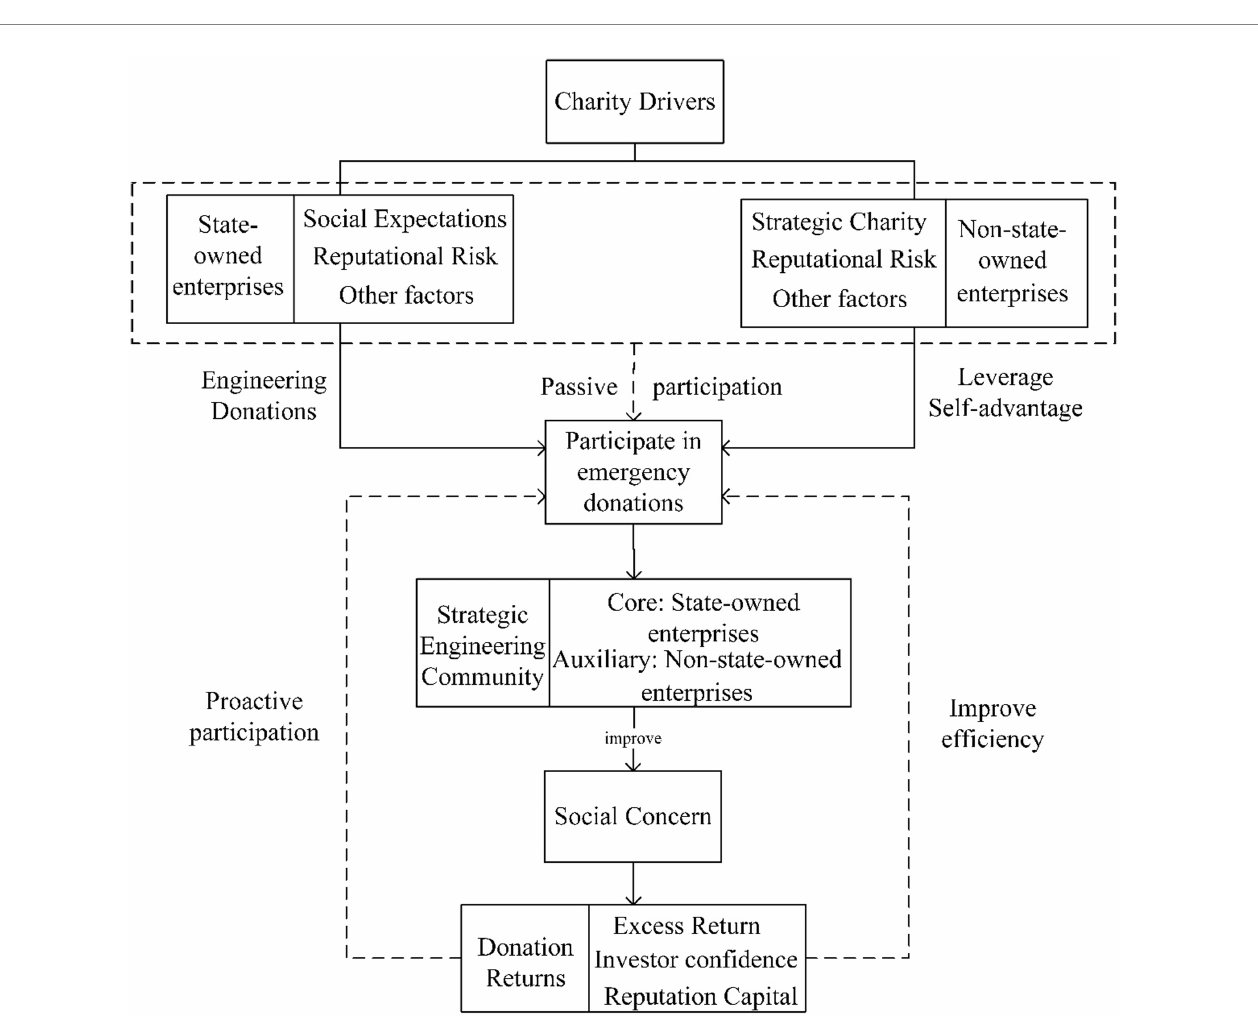
FIGURE 3 Logic diagram of construction companies’ participation in emergency